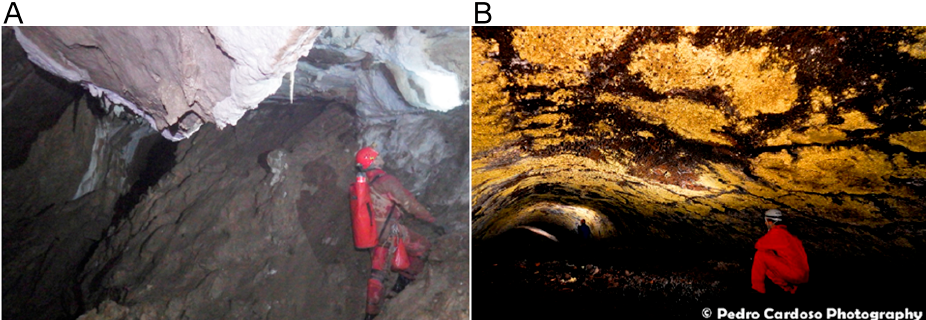
Figure 20. ( A ) An example of Moonmilk (above) in Goatherds Chasm in Switzerland. Photograph provided by Olivier Gallois of the Groupe Spéléologique Archéologique Mandeure; ( B )